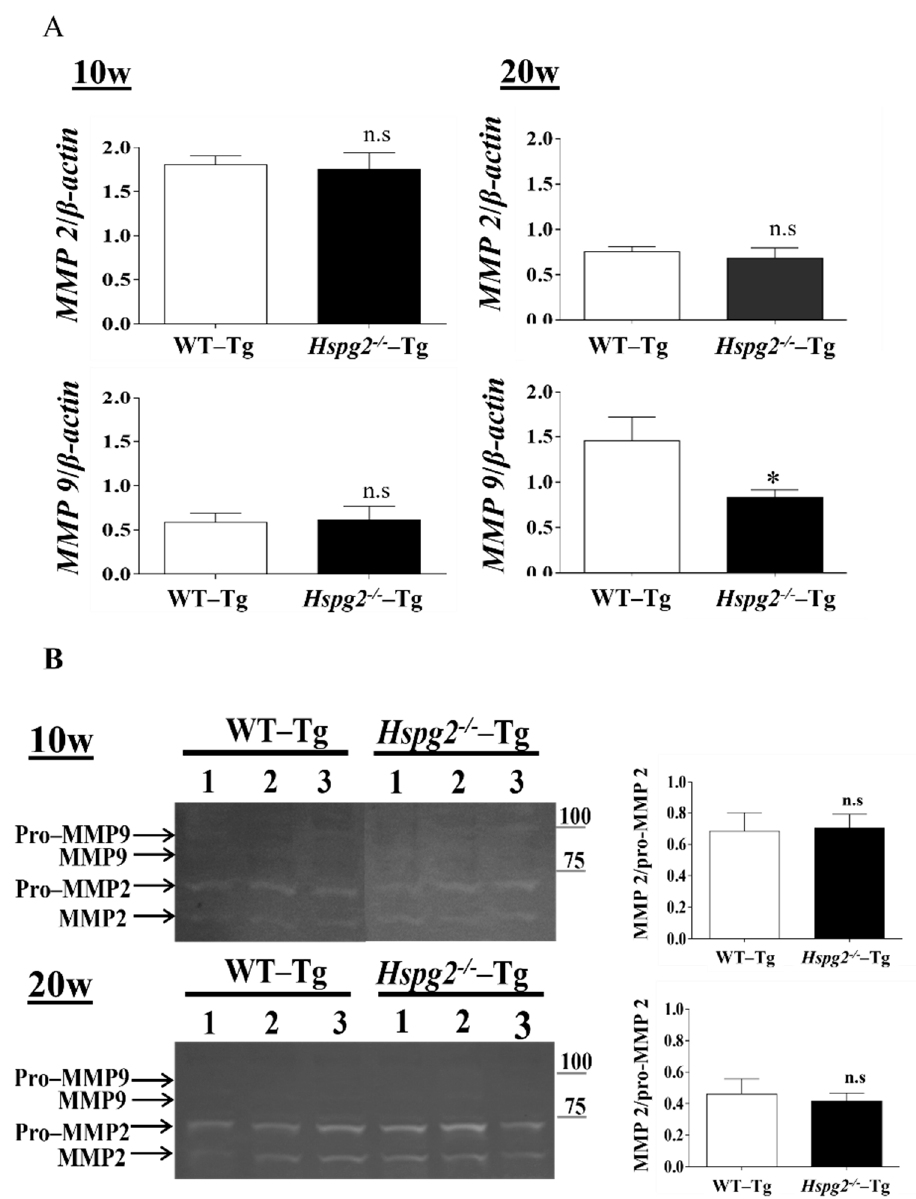
Figure 6. Expression and activity of matrix metalloproteinase (MMPs). ( A ) RNA expression of matrix metalloproteinase in Hspg2 − / − -Tg mice without AD showed no significant difference compared to that in WT-Tg mice. RNA expression levels were normalized to that of β -actin and are indicated as relative to the latter. (Mean ± SEM, 10 w; n = 6, 20 w; n = 3) ( B ) In gelatin zymography, MMP-2 activity did not differ, and MMP-9 activity was not detected in the aorta of WT-Tg and Hspg2 − / − -Tg mice without AD. MMP2 activity is indicated relative to pro-MMP2 activity. (Mean ± SEM, n = 3).